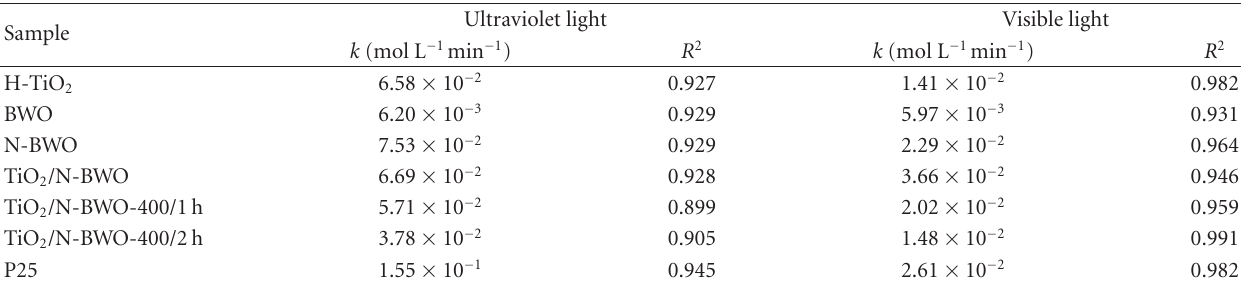
Table 5: The values of the photodegradation rate constant k for RhB and linearly dependent coe ffi cient R 2 .